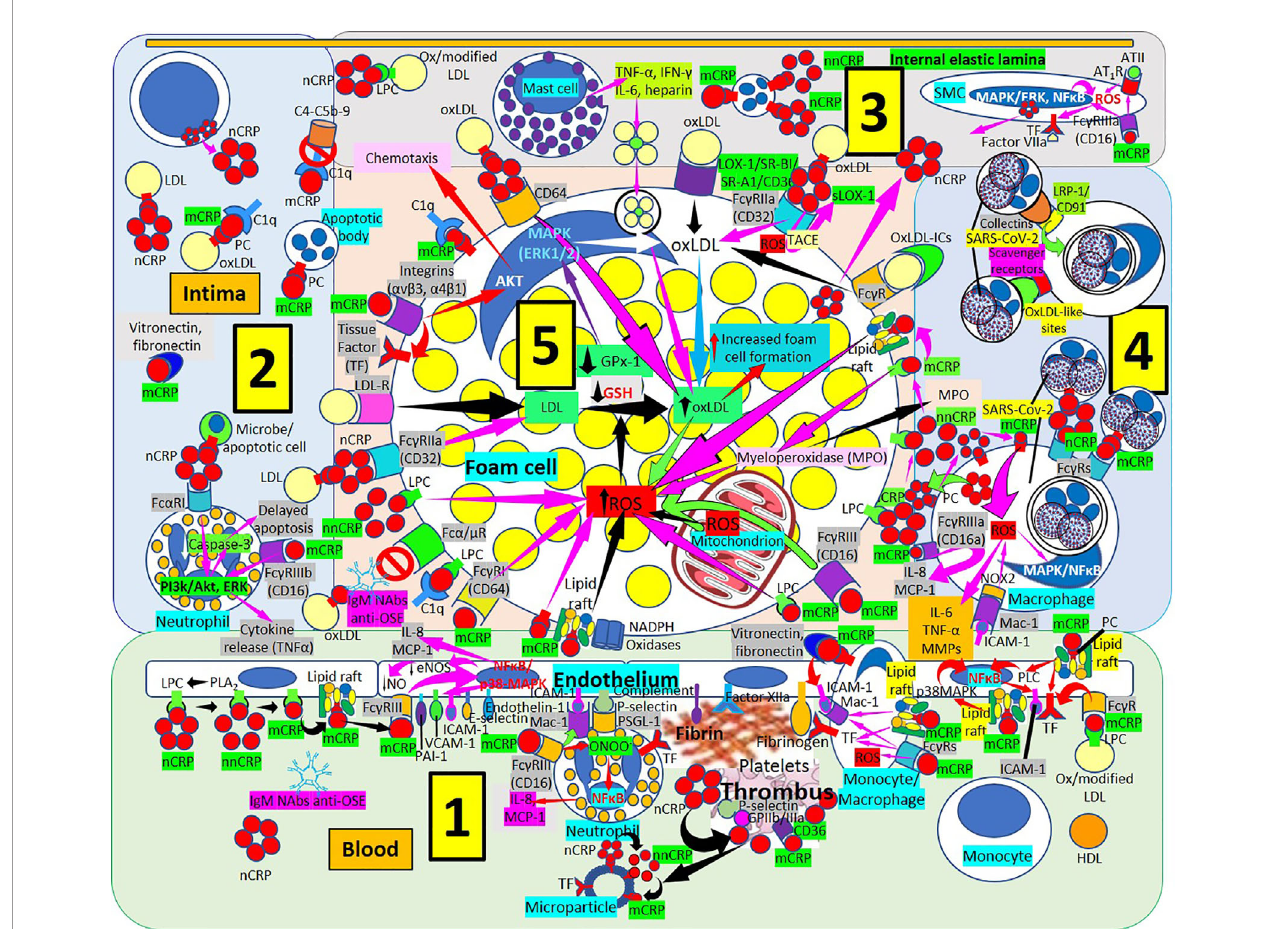
FIGURE 7 | Monomeric C-reactive protein in atherogenesis. [1] From right to left. Monomeric C-reactive protein (mCRP) bound to oxidized/modi fi ed (ox/modi fi ed) low density lipoprotein (LDL) through lysophosphatidylcholine (LPC) binds Fc g receptors (Rs) upregulates endothelial tissue factor (TF) (right in 1). Monomeric CRP bound to phosphorylcholine (PC) in lipid rafts activate intracellular signaling cascades (phospholipase C, PLC; p38 mitogen activating protein kinases, MAPK; nuclear factor k B, NF k B) enhancing endothelial intercellular adhesion molecule-1 (ICAM-1) (right in 1). Monocytes/macrophages adhere to endothelium following mCRP- mediated ICAM-1 and CD11b/CD18 (Mac-1) receptor upregulation; mCRP in monocytes/macrophages upregulate TF and Mac-1 and adhere to vitronectin/ fi bronectin in the intima (right in 1). TF, factor XIIa, fi brinogen and complement participate in thrombus formation and platelets generate further mCRP from nCRP. Interaction among mCRP, glycoprotein (Gp) IIb/IIIa, P-selectin and CD36 participate in in fl ammation and thrombus formation. Endothelial and platelet microparticles generate mCRP from nCRP and nonnative CRP (nnCRP) (center right in 1). Monomeric CRP facilitates endothelial neutrophil adherence via Fc g RIII and Mac-1 upregulation; neutrophil Mac-1 and P-selectin glycoprotein ligand (PSGL)-1 attach to ICAM-1 and P-selectin, respectively; mCRP- Fc g RIII enhance peroxinitrite (ONOO - ) generation, NF k B activation and IL-8 and monocyte chemoattractant protein-1 (MCP-1) release (center in 1). Endothelial phospholipase A 2 (PLA 2 ) generates LPC facilitating monomerization of CRP that binds lipid rafts and Fc g RIII and activates NF k B/p38MAPK, upregulating plasminogen activator inhibitor (PAI)-1, vascular cell adhesion molecule (VCAM)-1, E-selectin and endothelin-1; downregulating endothelial nitric oxide synthase (eNOS) and nitric oxide (NO); and enhancing IL-8 and MCP-1 release (left and center left in 1). [2] CRP via Fc a RI and mCRP via Fc g RIIIb can activate phosphatidylinositol 3-kinases/protein kinase B and extracellular signal-regulated kinases (PI3k/AKT, ERK) signaling pathways in intimal neutrophils and enhance tumor necrosis factor- a (TNF- a ) release and delay apoptosis. T-cells can produce CRP enhancing intimal CRP. [3] Mast cells contribute to oxLDL macrophage uptake through TNF- a , interferon- g (IFN- g ), IL-6 and heparin secretion. CRP can be synthesized by smooth muscle cells (SMC) and foam cells, and Fc g RIIIa-bound mCRP in SMCs induce ROS and upregulate TF enhancing thrombus formation through factor VII activation; mCRP can upregulate angiotensin (AT) 1 R and ATII-mediated ROS production. [4] LRP-1/CD91 and scavenger receptors facilitate collectin- and oxLDL-like site-mediated severe acute respiratory syndrome coronavirus-2 (SARS-CoV-2) uptake, respectively, and Fc g Rs can facilitate nCRP and mCRP-mediated SARS-CoV-2 macrophage phagocytosis; mCRP and ICAM-1 can mediate ROS formation and subsequent release of IL-8, MCP-1, IL-6, TNF- a and matrix metalloproteinases (MMPs). [5] Increased ROS formation, reduced glutathione (GSH) and glutathione peroxidase (GPx)-1 activity increase foam cell formation sustaining in fl ammation in the plaque (center in 5). OxLDL bound to IgM natural antibodies (NAbs) can block Fc a / m -mediated oxLDL uptake. Monomeric CRP bound to lipid rafts, LPC, PC or Fc g Rs and LPC-bound nonnative CRP (nnCRP) could enhance ROS formation; and LPC bound mCRP activate C1q (lower left in 5). CRP/CD32 and LDL-R facilitate macrophage LDL uptake (center left in 5). CRP bound to CD64 enhance oxLDL uptake and foam cell formation; mCRP contributes to intimal in fl ammation, integrin-mediated TF upregulation and chemotaxis and C1q activation (upper left in 5). Scavenger receptors lectin-like oxidized low-density lipoprotein (LDL) receptor-1 (LOX-1), scavenger receptor class B type 1 (SR-BI), scavenger receptor A1 (SR-A1), and CD36,facilitate oxLDL macrophage uptake; and Fc g Rs CRP-bound oxLDL and oxLDL immune complexes (oxLDL-ICs) (upper center and upper right in 5). LPC membrane-bound nCRP dissociates into mCRP with intermediate nnCRP formation, and mCRP can induce myeloperoxidase (MPO) synthesis and release; LPC- and lipid raft-bound mCRP can enhance ROS formation (right in 5). Monomeric CRP bound to CD16 or LPC can enhance foam cell ROS (right in